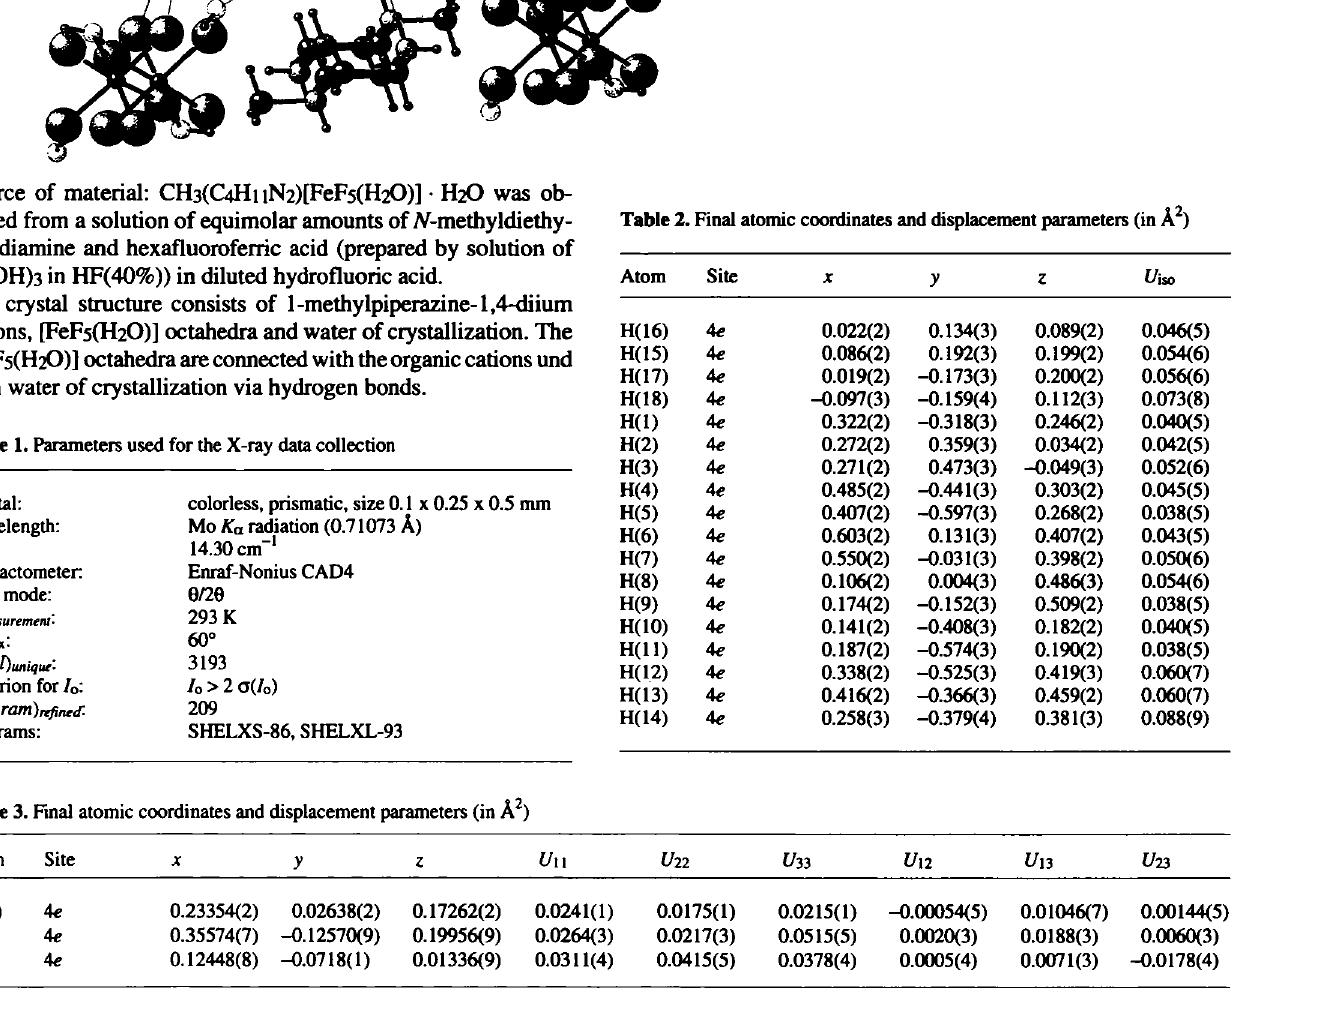
Table 3. Final atomic coordinates and displacement parameters (in Â 2 )